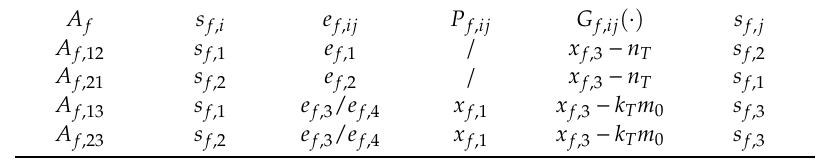
Figure 1. State transfer diagram of a single flywheel. Table 1. State transfer relation of flywheel f A .